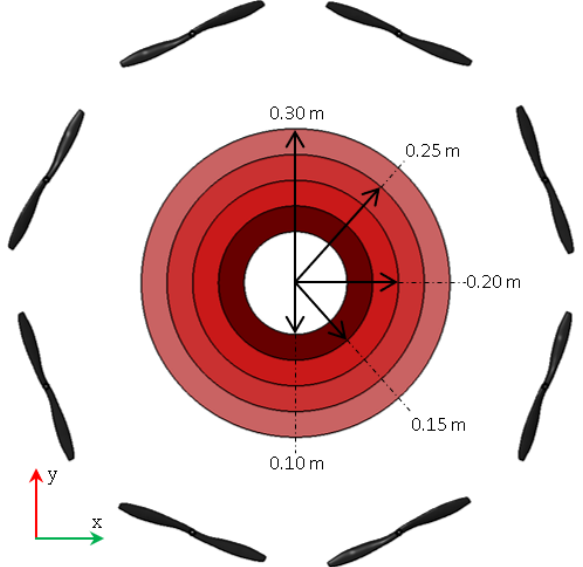
Figure 6. This figure shows the particle sampling regions and their radii across one of the parallel sampling planes. The planes had z co- ordinates – relative to the propeller plane – between 0 and 0.3m with an equal spacing of 0.05m and were all identical. The pro- pellers are shown here as a reference. The axis labelling system is consistent with Fig.